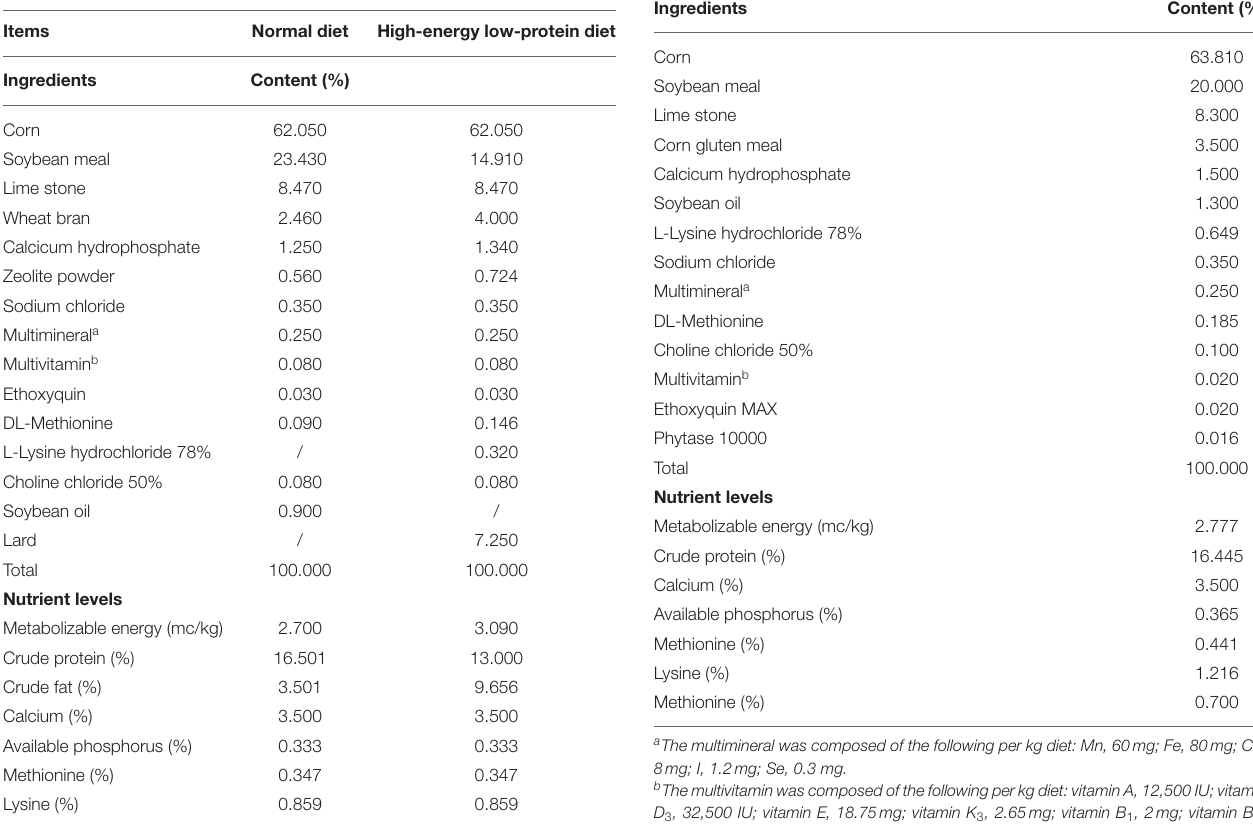
TABLE 1 | Composition and nutritional levels of the normal and high-energy low-protein diet of FLHS laying hens. Items